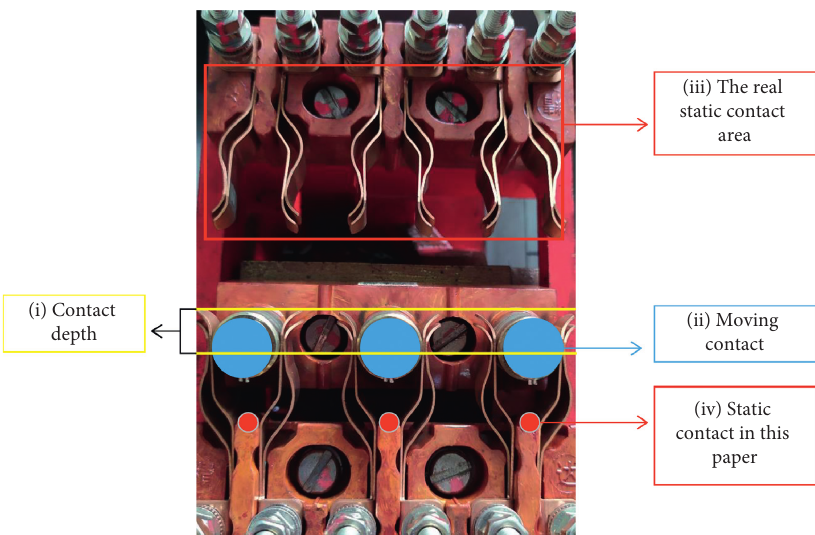
Figure 1: Internal structure diagram of switch machine. (i) The contact depth: the depth of the moving contact driving into the static contact. (ii) The moving contact. (iii) The real static contact area. (iv) The static contact in this